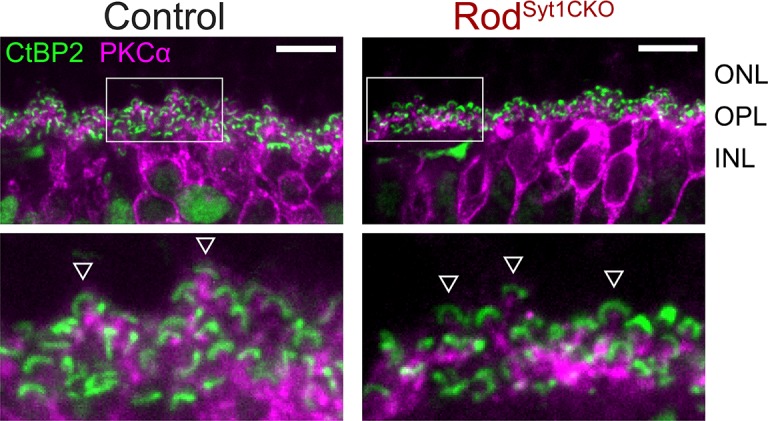
Rod bipolar cell dendrites maintain contact with rod ribbon synapses in the OPL of RodSyt1CKO retinas.Images of control and RodSyt1CKO retinas labeled with antibodies to CtBP2 (ribbons, green) and PKCα (rod bipolar cells, magenta). Boxes within images on the top indicate the boundaries of high magnification images shown below. Exemplar rod ribbon-rod bipolar cell dendrite contacts are indicated with arrowheads. Scale bars = 10 µm.